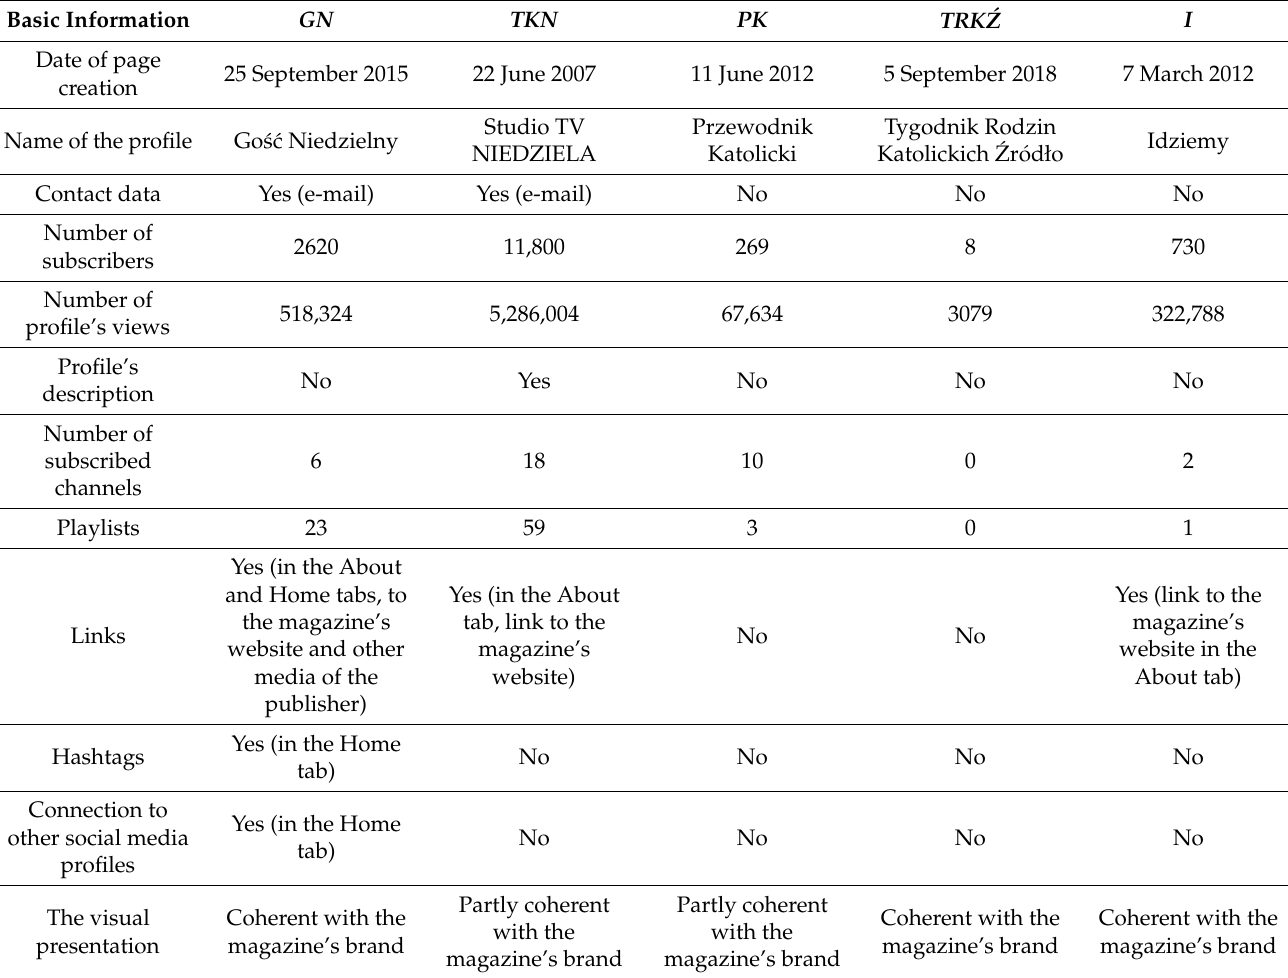
Table 3. Comparison of the YT profiles—analysis results (as of 27 July